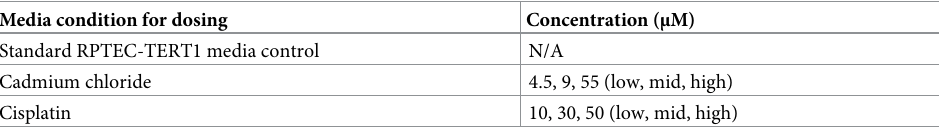
Table 1. Media conditions for injury